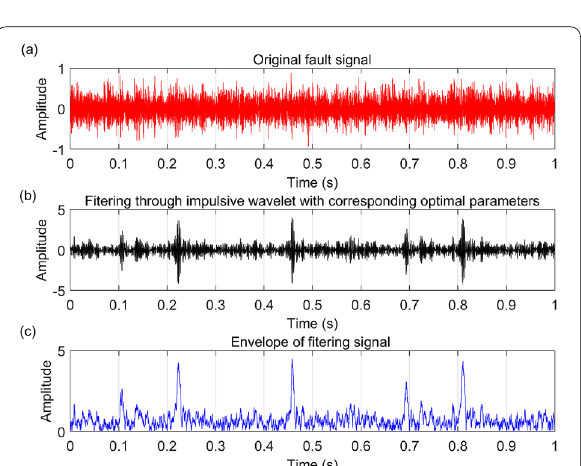
Figure 20 Tooth broken fault signal processed by the maximum correlation coefficient method: ( a ) original signal, ( b ) signal after filtering by impulsive wavelet, and ( c ) the envelope of the processed signal